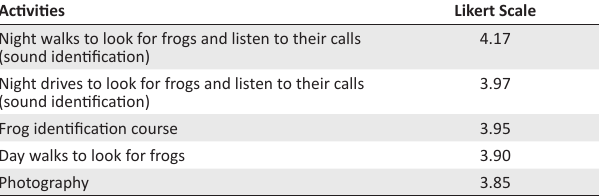
TABLE 4: The top five frogging activities represented in a Likert scale. Activities Likert